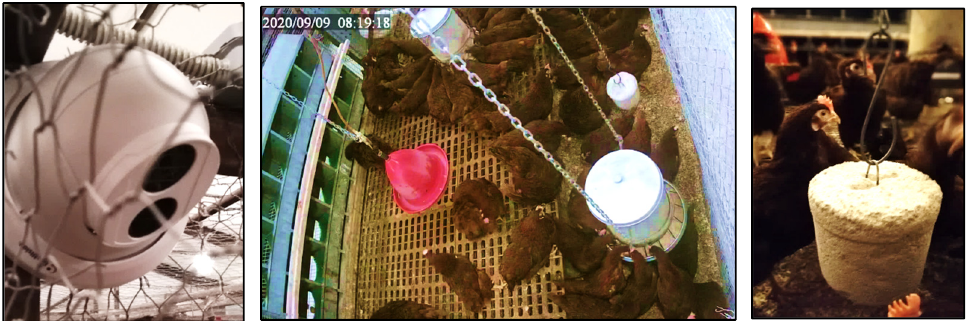
Figure 2. Infrared camera installed in the pen; HD-quality recording; pen interior layout with sus- pended beak wear material.